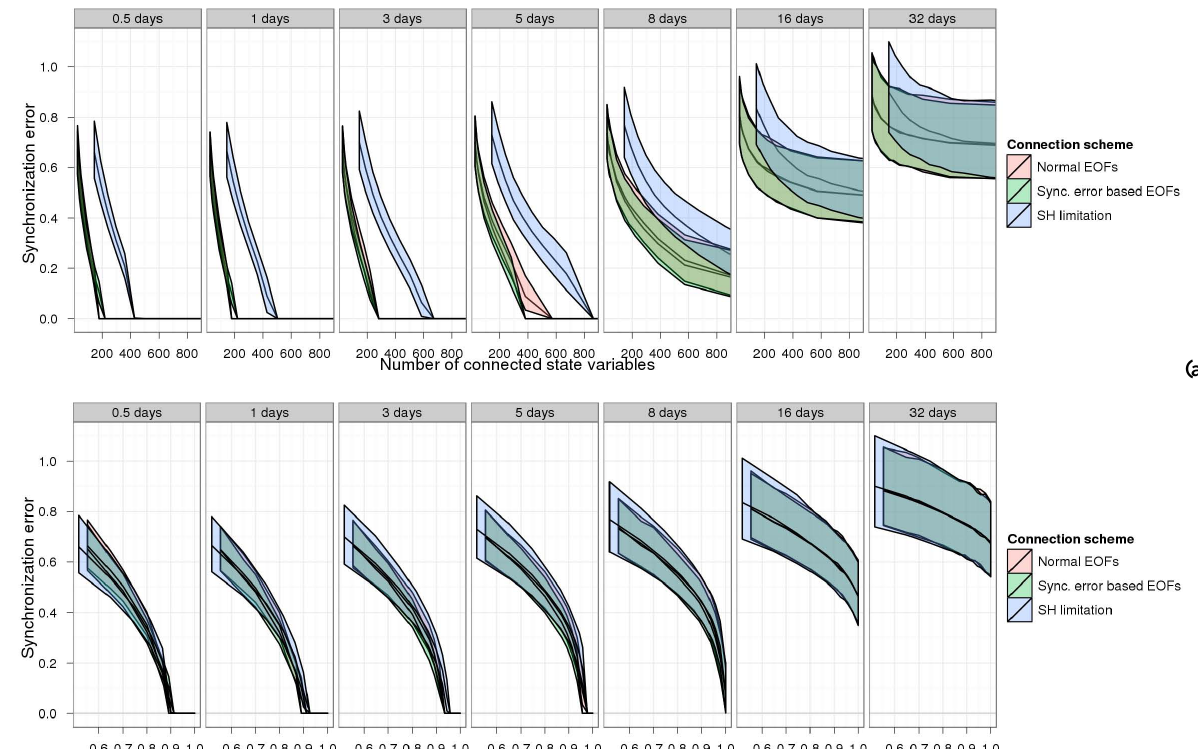
Fig. 6. (a) Number of state variables connected and (b) variance captured in the connected subspace, versus the scaled synchronization error, i.e. the degree of synchronization, for several T n values, and for a number of connection schemes. The shaded areas show the 95% quantile interval. The SH connection scheme works by connecting only the low